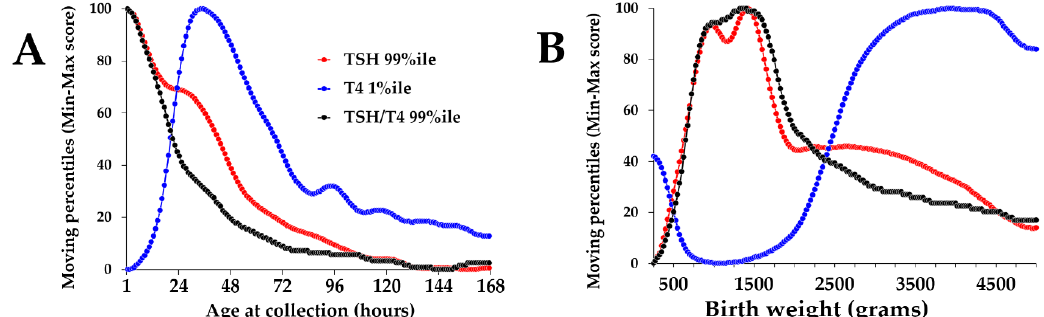
Figure 5. Normalized moving percentiles of TSH, T4, and the TSH/T4 ratio by age and birth weight. Legend: (Panel A ): Normalized moving percentiles by age, range 1–168 h (1 week). Color coding of markers is embedded in the plot. (Panel B ): Moving percentiles by birth weight, range 250–5000 g. First occurrence of maximum value: TSH: age 1 h and birth weight 1425 g; T4: age 34 h and birth weight 3825 g; TSH/T4 ratio: age 1 h and birth weight 1325 g.